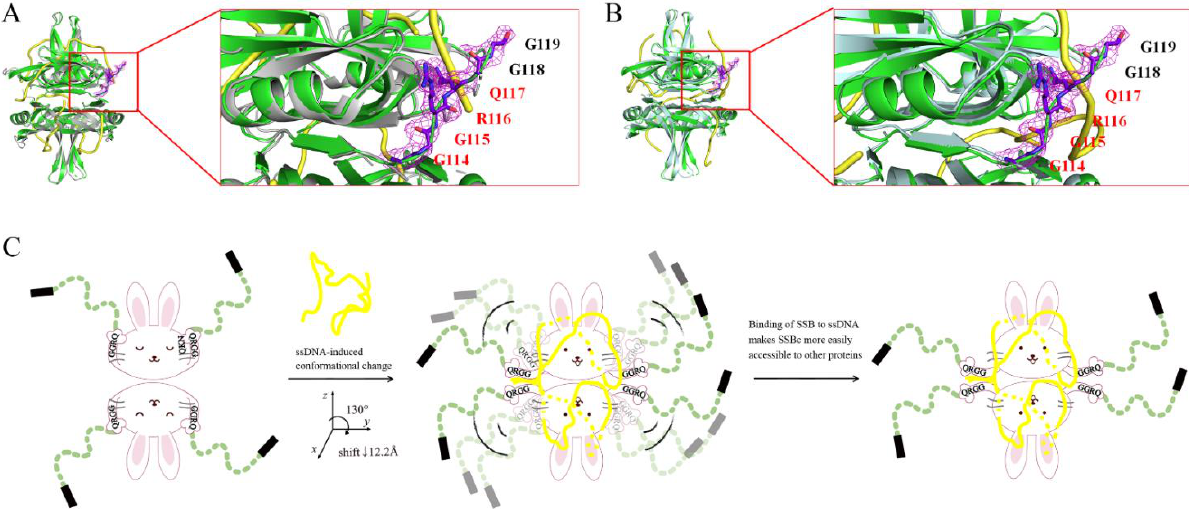
Figure 9. The 114-GGRQ-117 motif as a regulatory switch for ssDNA binding. ( A ) The superimposed structures of KpSSB and the EcSSB-ssDNA complex. KpSSB and EcSSB are colored in green and gray, respectively. ssDNA is colored in yellow. ( B ) The superimposed structures of KpSSB and the PaSSB-ssDNA complex. PaSSB is colored in pale cyan. Six additional residues, 114-GGRQGG-119, were observed in the structure of KpSSB. This region was not visible in the structures of the EcSSB- and PaSSB – ssDNA complexes. The 114-GGRQ-117 motif labeled in red interacted with Asn14, Lys74, and Gln77 in KpSSBn via several hydrogen bonds. The GGRQ motif-interacting residues Asn14, Lys74, and Gln77 in KpSSB are ssDNA-binding residues in EcSSB- and PaSSB – ssDNA complexes. ( C ) A cartoon model. The GGRQ motif might be a regulatory switch for SSBn or ssDNA binding. In the structure of apo-KpSSB, the GGRQ motif interacted with Asn14, Lys74, and Gln77 via several hydrogen bonds. Superimposing analysis indicated that if binding of the EcSSB – ssDNA complex occurs, the GGRQ peptide in KpSSB will break free from these hydrogen bonds and shift away by a distance of 12.2 Å and angles of 130˚ to form a complex with ssDNA. The binding of ssDNA might be a driving force to promote the conformational change in the GGRQ motif. Thus, binding of SSB to ssDNA makes SSBc more easily accessible to other proteins.